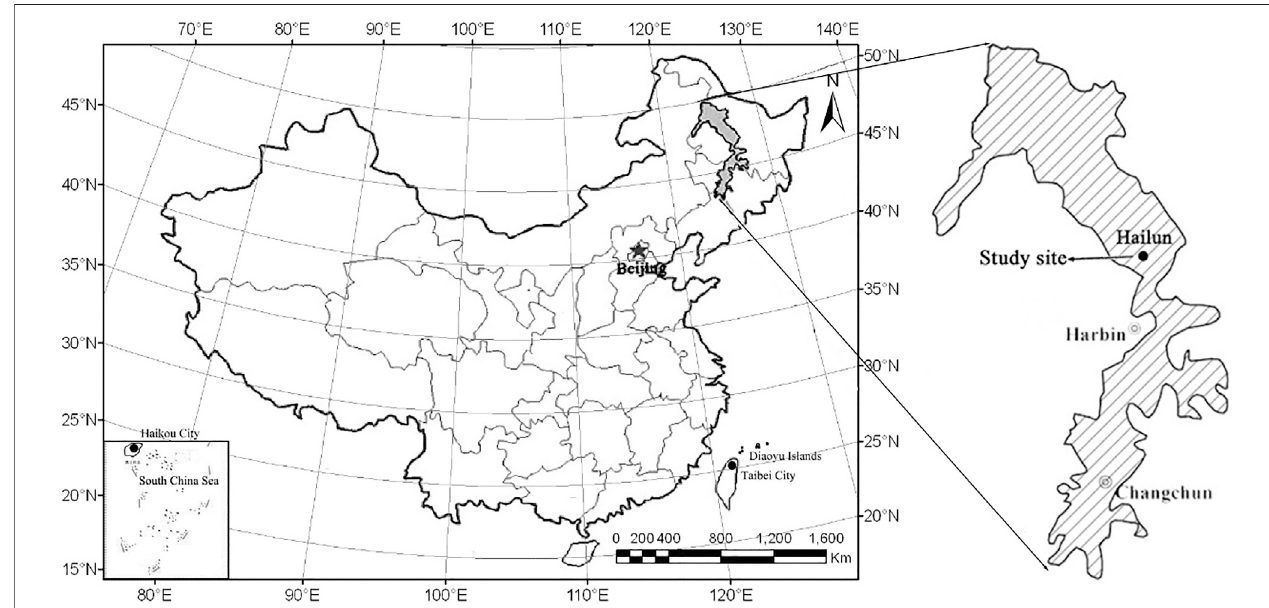
FIGURE 1 | The study site at different geographical scales in a map of